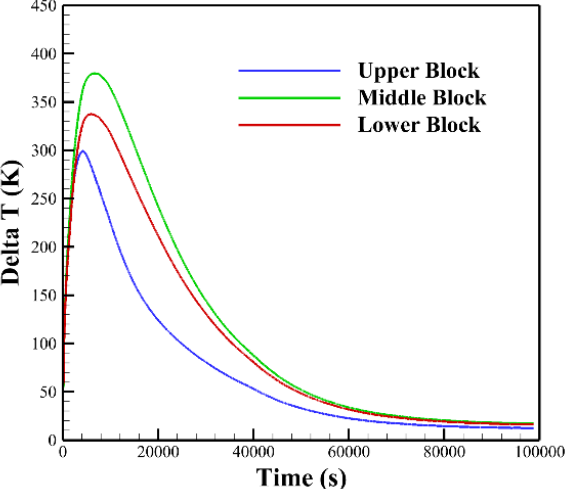
Figure 11. Transient histories of blocks’ temperature non-uniformities in Config-2-S0.